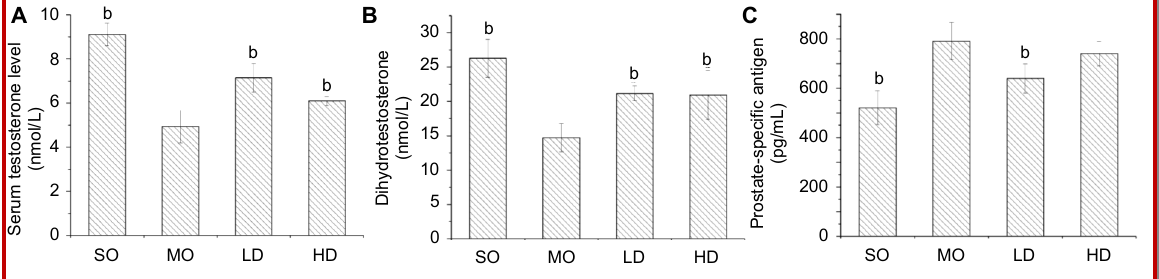
Figure 1: Effect of T. patula water extract on the levels of serum testosterone, dihydrotestosterone and prostate-specific antigen levels. Values are in mean ± SD; (n = 10), a = p<0.05, b = p<0.01 Vs the model group (MO)